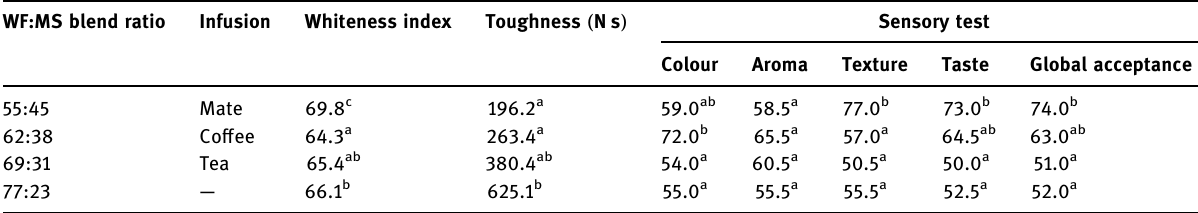
Table 1: Colour ( whiteness index ) , texture ( toughness ) , and results of the sensory test of biscuits prepared with wheat fl our ( WF ) and maize starch ( MS ) of blends and with infusion addition